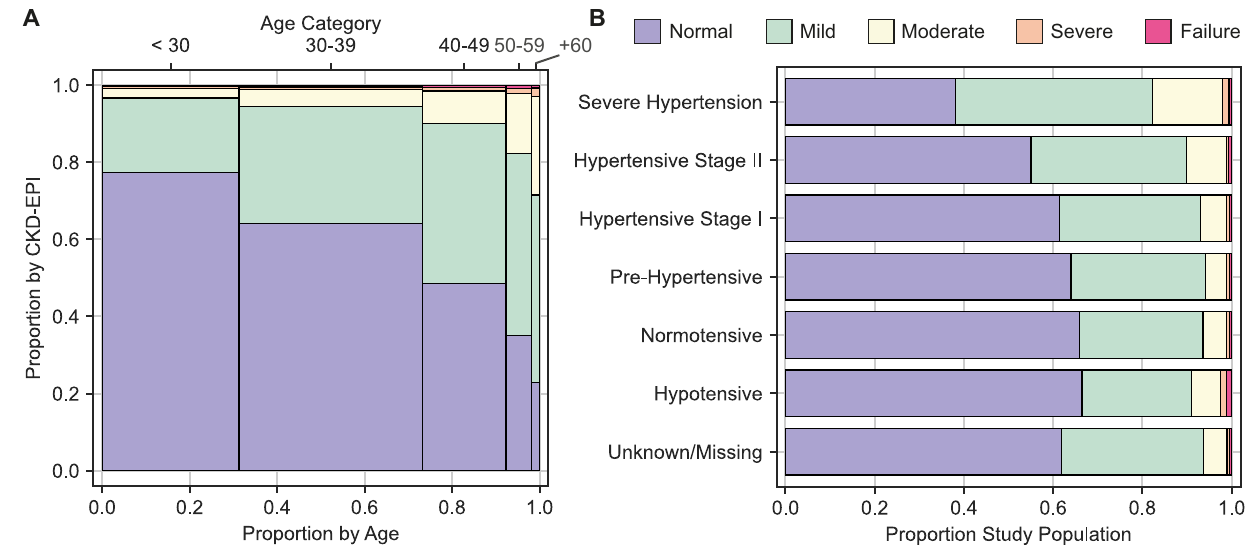
Fig 1. A) Mosaic Plot Estimated Glomerular Filtration Rate (eGFR) Category by Age Category B) Stacked Bar Chart eGFR Category by Hypertensive Category. Notes: The visit interval is 0 at ART initiation/baseline, individual follow-up time limited to two